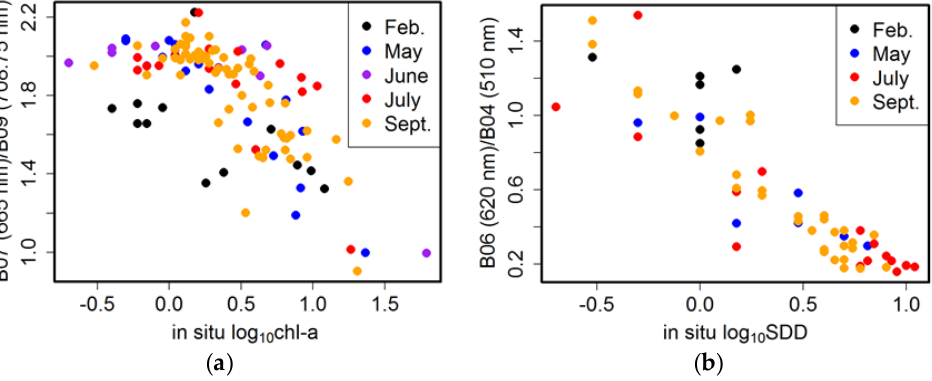
Figure 4. Correlation coefficients between MERIS atmospherically corrected reflectance ratio and in situ chl-a ( a ) and between MERIS atmospherically corrected reflectance ratio and in situ SDD ( b ) R1 and R2 represent nominator and denominator, respectively. Values along the diagonal line from lower left to top right indicate correlation with reflectance of a single wavelength. Resulting scatterplots of selected band ratios against in situ data are shown in Figure 5 for chl-a concentration and SDD measurements.